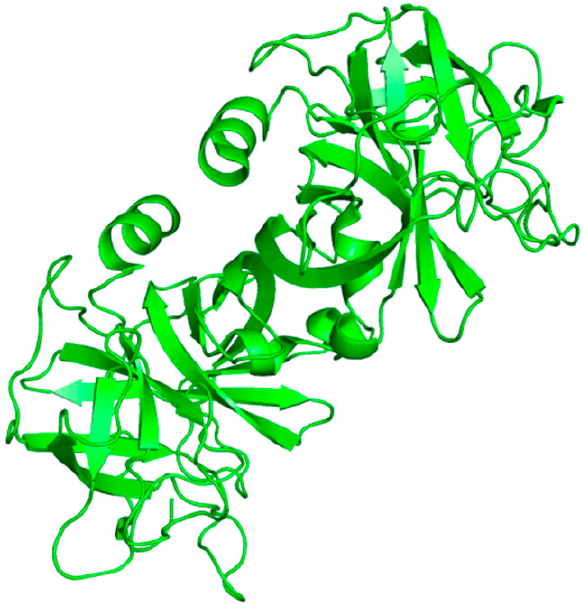
Figure 1. Structure of free human neutrophil elastase (HNE) from the RCSB Protein Data Bank (PDB-ID: 3Q76) [15,16].